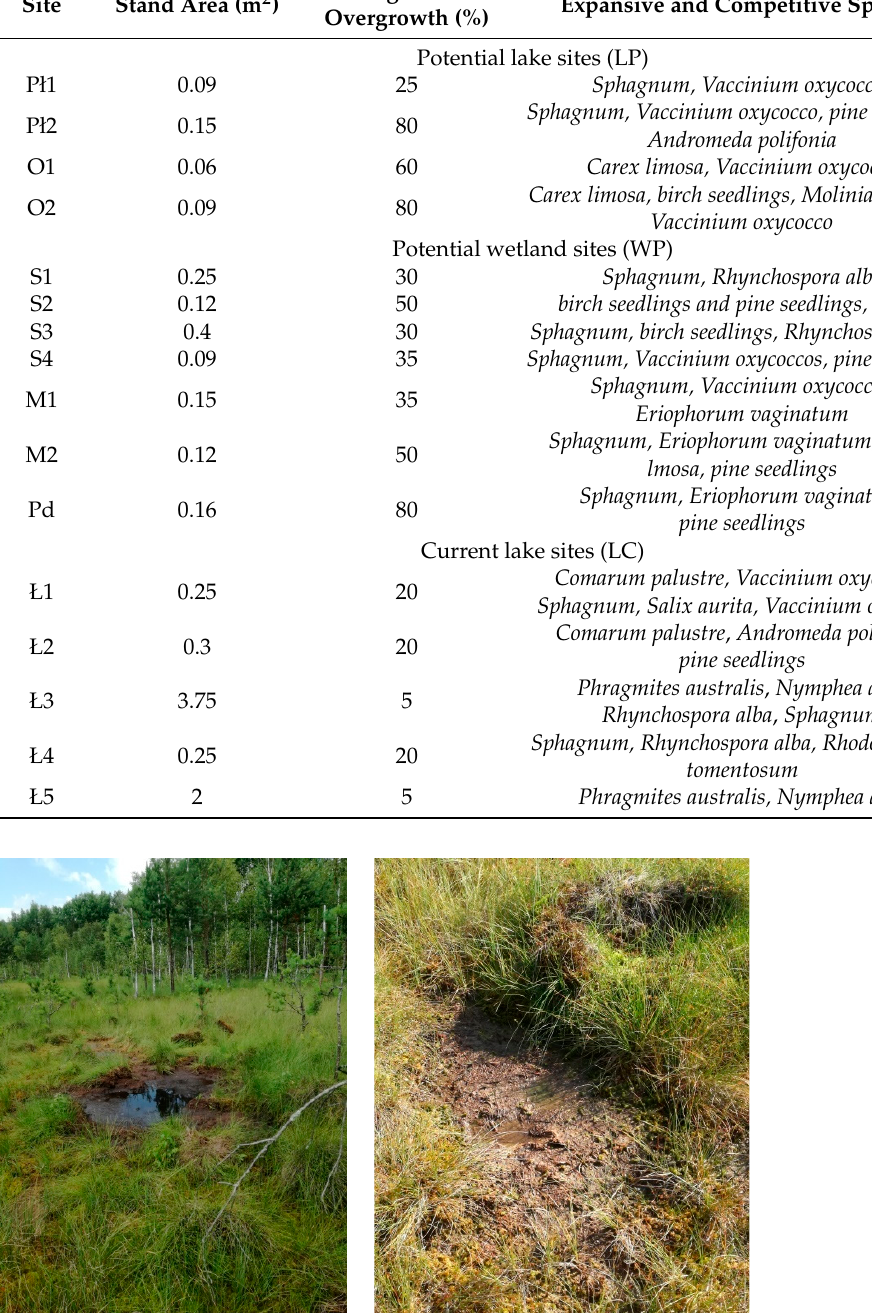
Table 3. Characteristics of sundew sites. The degree of the overgrowth of reintroduction sites is prior to their preparation for planting.